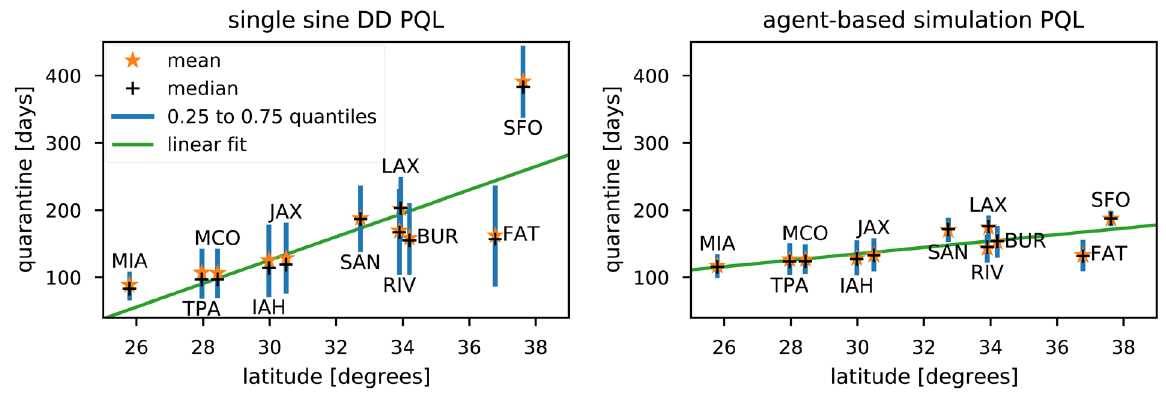
Figure 5. Predicted quarantine length dependence on latitude. For each site, the mean, median, and inter-quartile range are shown, similar to a boxplot. An ordinary least-squares linear fit to the median values is shown by the green lines. The left panel is for single sine degree day predictions, and MED-FOES ABS based predictions are in the right